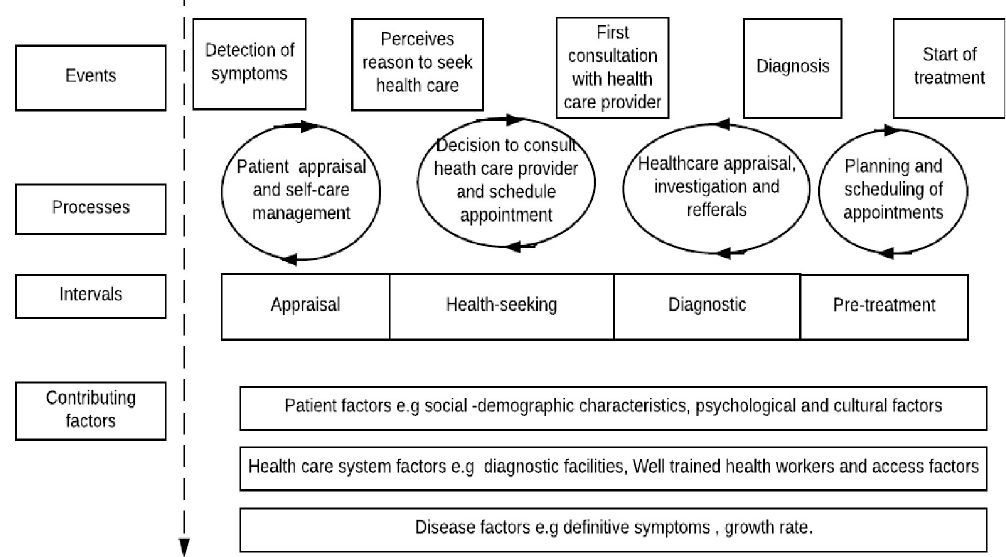
Fig 1. The model of pathways to treatment according to Scott et al.